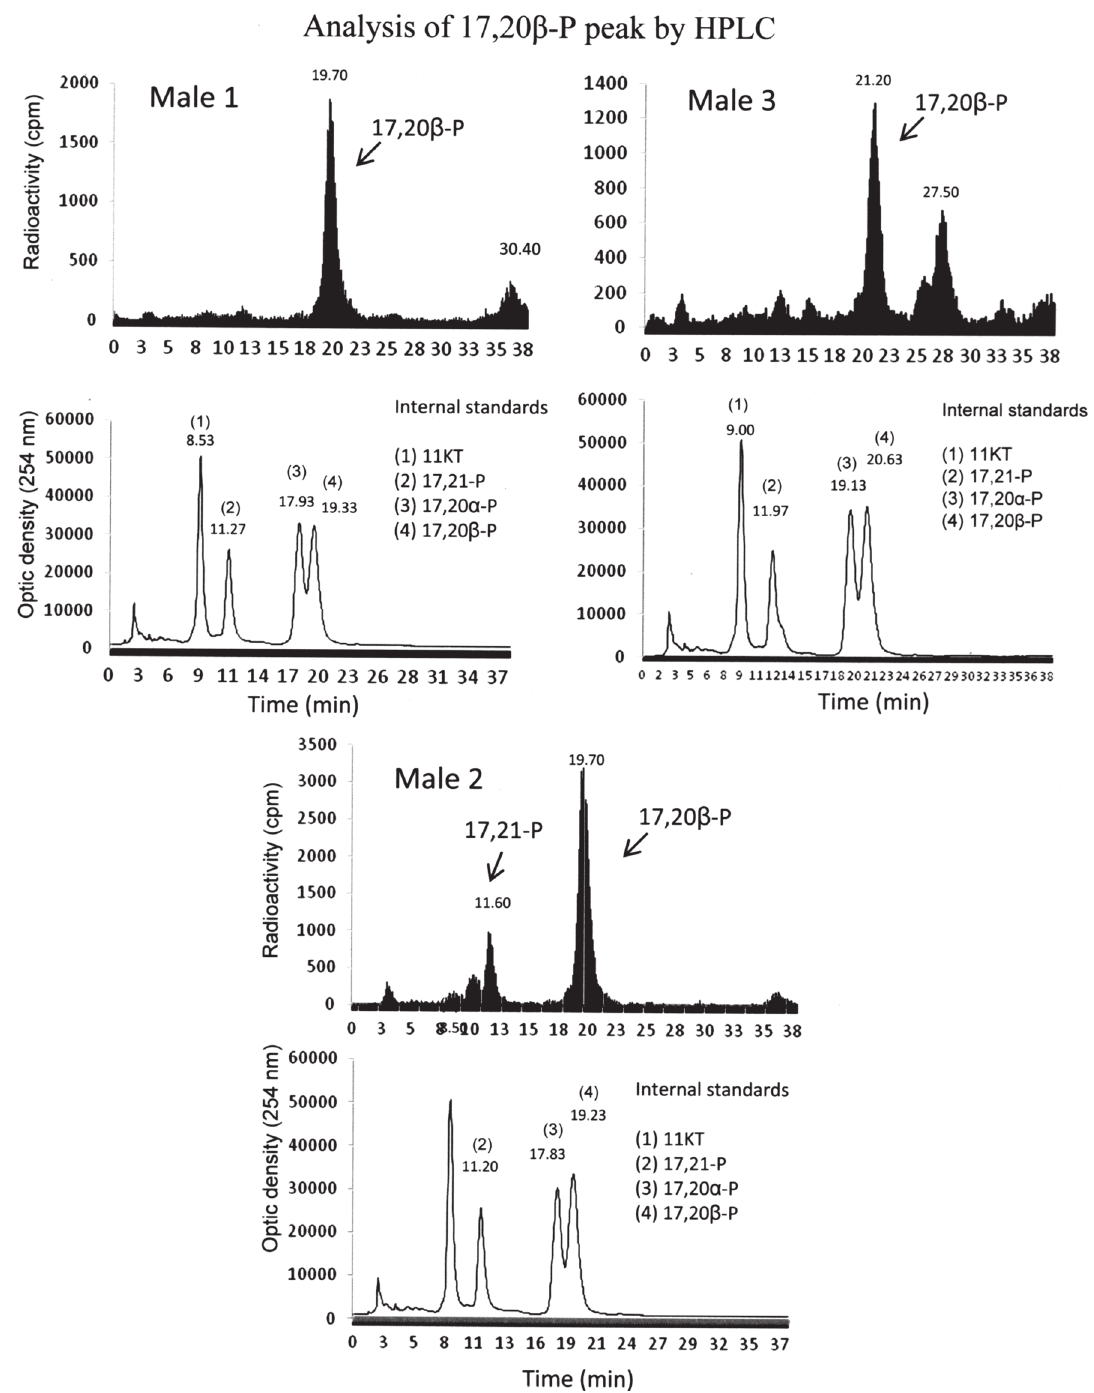
Fig. 3. Analysis of zone C of TLC or di-hydroxylated progestins area (see Fig. 1) by HPLC using methanol/acetonitrile/water 33/26/41 v/v/v (system III) in Micropogonias furnieri . 17,20βP circulating levels during the testicular